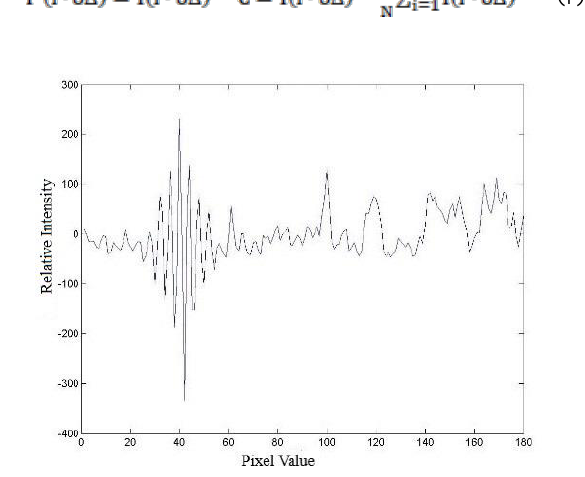
Figure 4. Remove the DC component